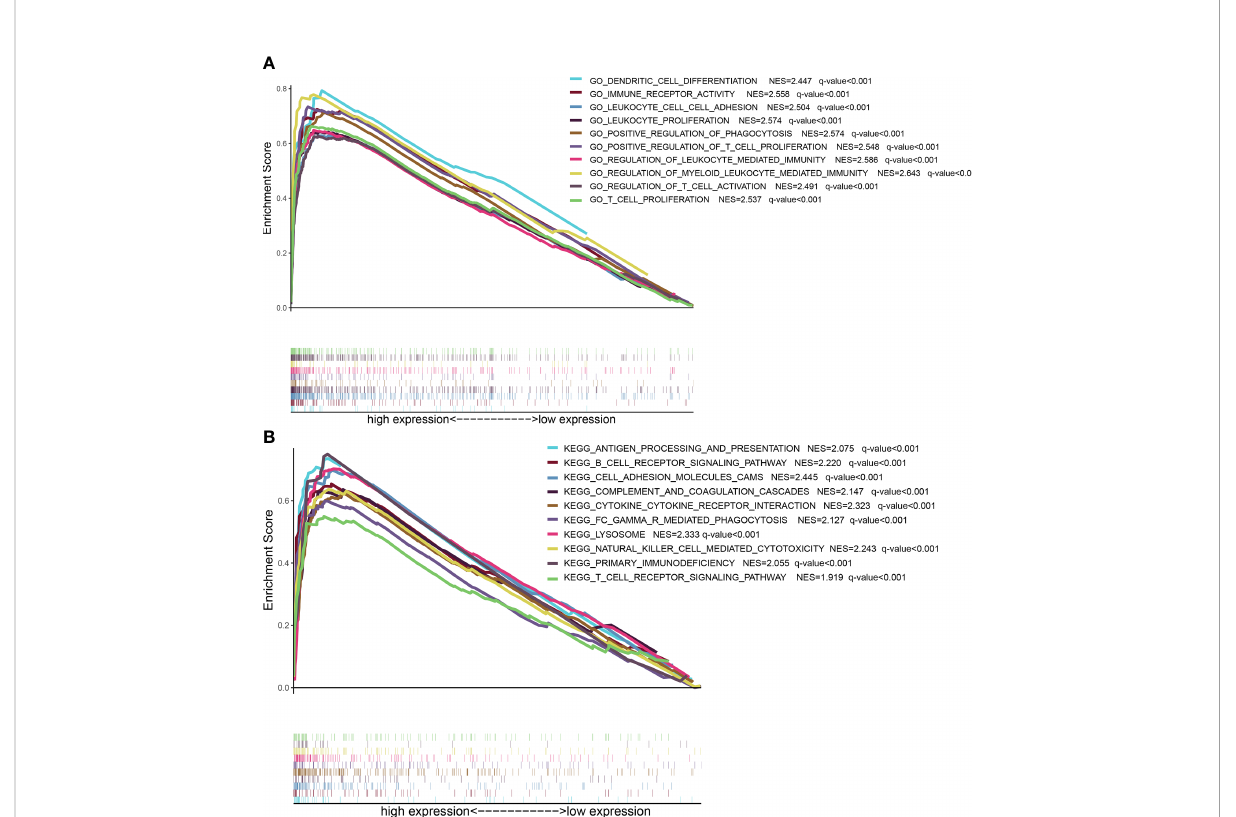
FIGURE 6 GSEA analysis based on LPAR5 expression. (A) The enriched gene sets of high LPAR5 expression group in GO collection. (B) The enriched gene sets of high LPAR5 expression group in KEGG